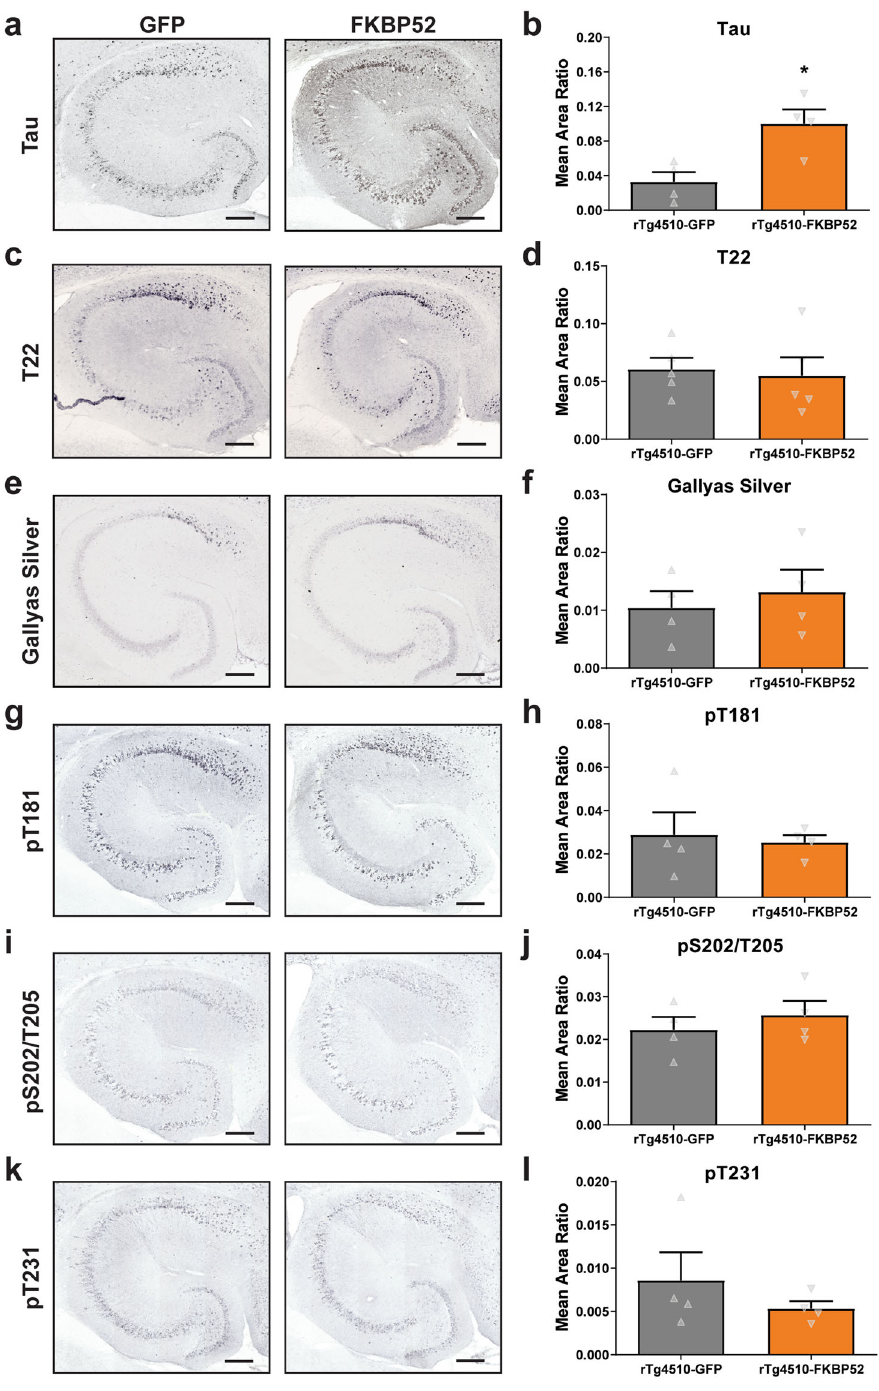
Fig. 6 FKBP52 overexpression in rTg4510 mice does not alter phosphorylated tau. Tissue from AAV9-GFP and AAV9-FKBP52 injected rTg4510 mice was stained and analyzed for ( a – b ) total tau (DAKO), ( c – d ) T22, ( e – f ) Gallyas silver, ( g – h ) pT181 tau, ( i – j ) AT8 antibody recognizing tau phosphorylation at Ser202/Thr205 sites, and ( k – l ) AT180 antibody recognizing tau phosphorylation at Thr231 site. Protein levels were analyzed by unpaired t test, where statistical signi fi cance is considered by * p < 0.05 Results represented as standard error of the mean (±SEM); GFP, n = 4; FKBP52, n = 4;). Scale bars are 200 μ m in the hippocampal tissue sections. GFP green fl uorescent